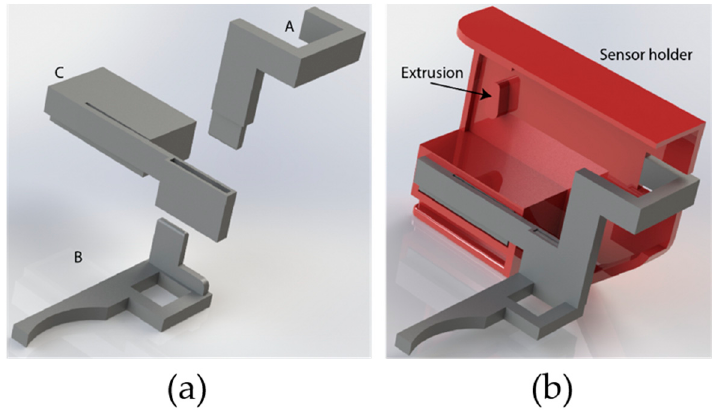
Figure 5. 3D-printed components to provide “plug-and-play” deployment and operation within sanitizer dispensers: ( a ) compliant mechanism and ( b ) sensor module holder.